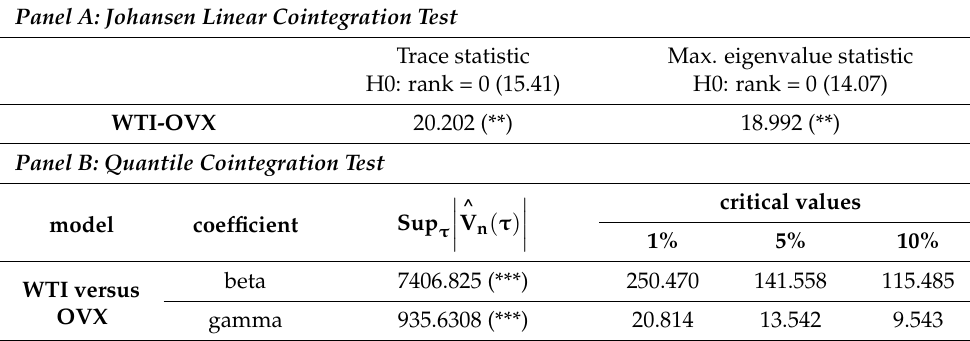
Table 5. Results of linear and quantile cointegration